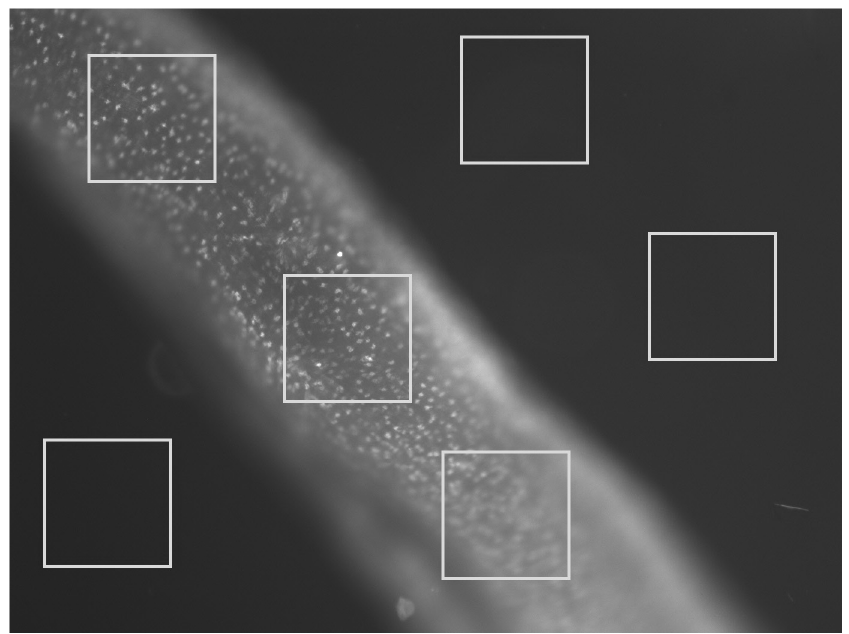
Fig 3. Schematic representation of the worm areas analysed by ImageJ. Fluorescence quantification was made in three defined regions, of the same size, corresponding to the worm central section (below the cecum ramification), of each worm and fluorescence intensity within each region was quantified using ImageJ software (imagej.nih.gov) and background intensity was subtracted.